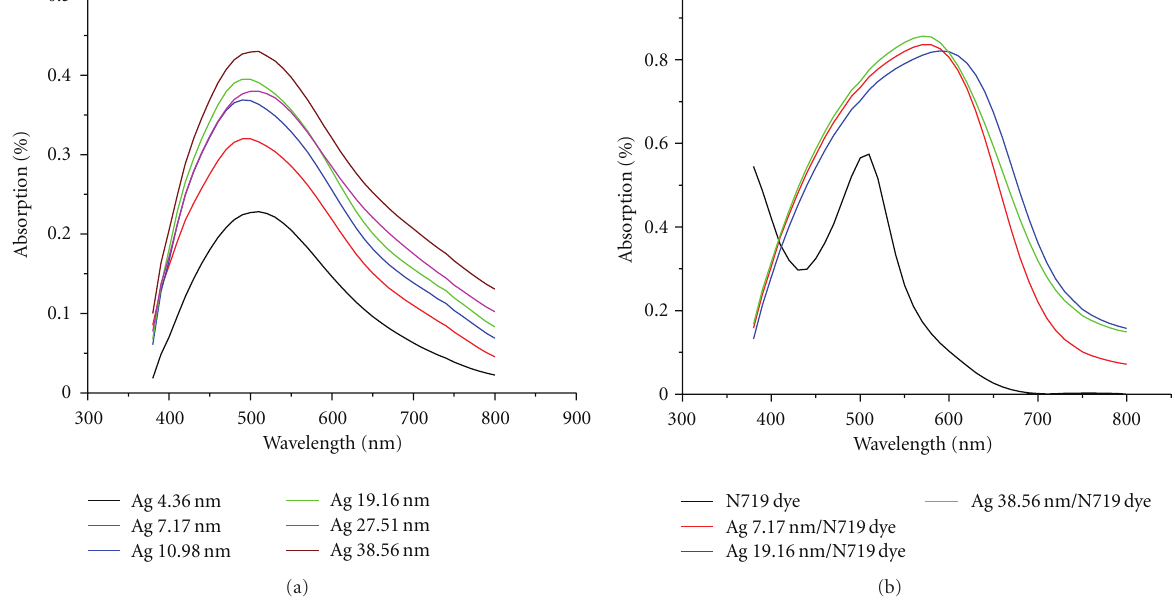
Figure 6: Optical absorption spectra of: (a) the Ag nanoparticle films with various particle sizes of the Ag nanoparticles in the range of 4.36–38.56 nm and (b) the Ag/N719 dye film compared with an optical absorption spectrum of 3 × 10 − 5 M N719 dye